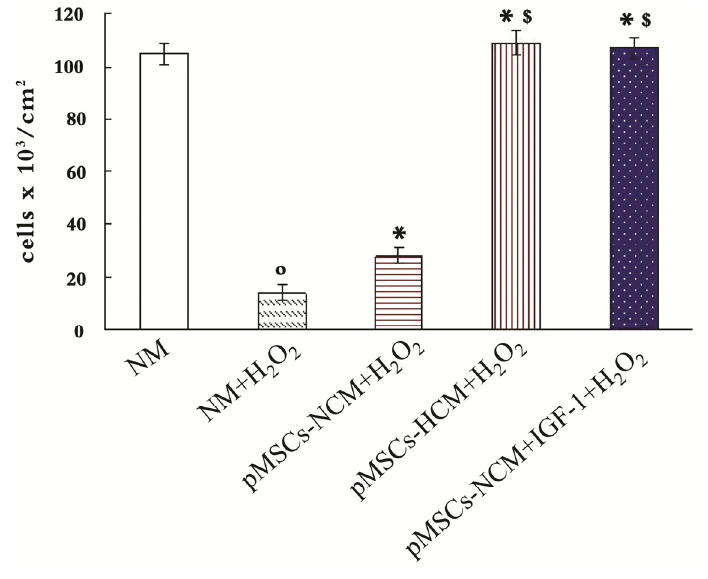
O -treated-caco2 cells in NM, 2 2 O 2 2